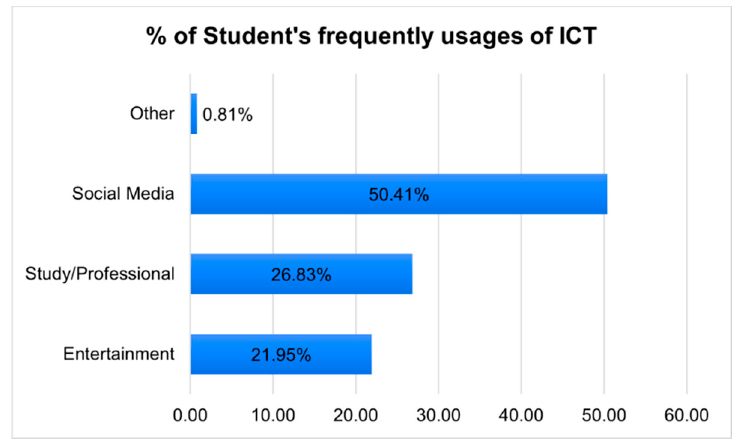
Figure 6. Most frequently, usage of ICT by students during the COVID-19 pandemic.